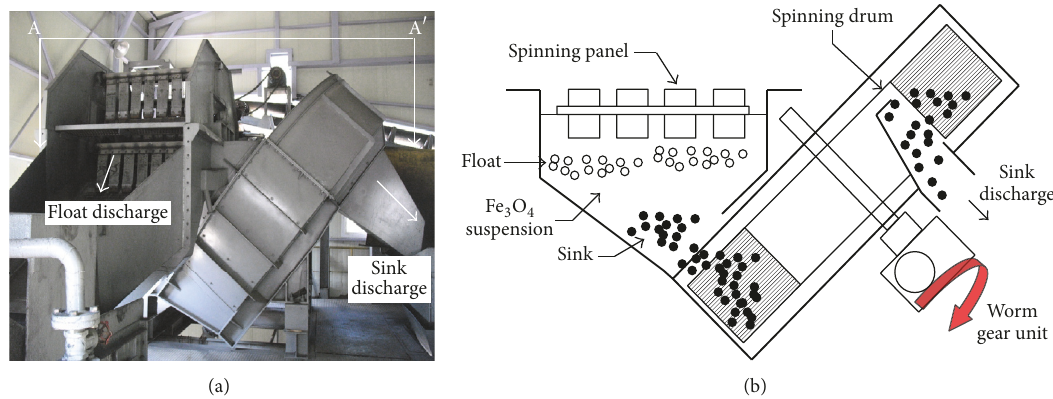
Figure 4: Prototype equipment of dense medium separation process using Fe 3 O 4 suspension (a) and the sectional view A-A 󸀠 in Figure